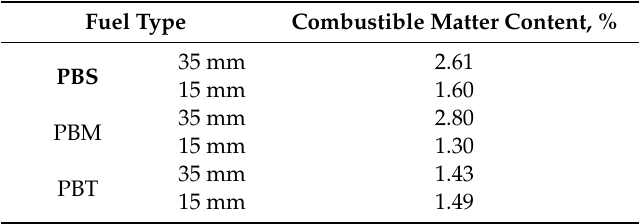
Table 5. Combustible matter content in slag and ash from sewage sludge